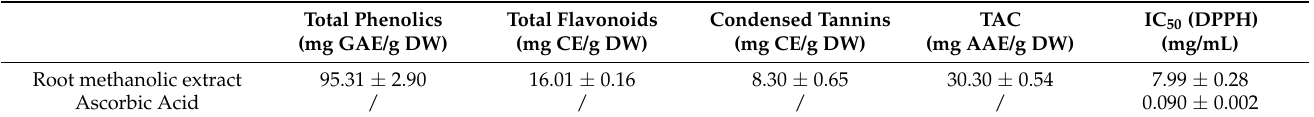
Table 2. Quantitative estimation of the polyphenolic contents, total antioxidant capacity, and IC 50 concentration in the DPPH